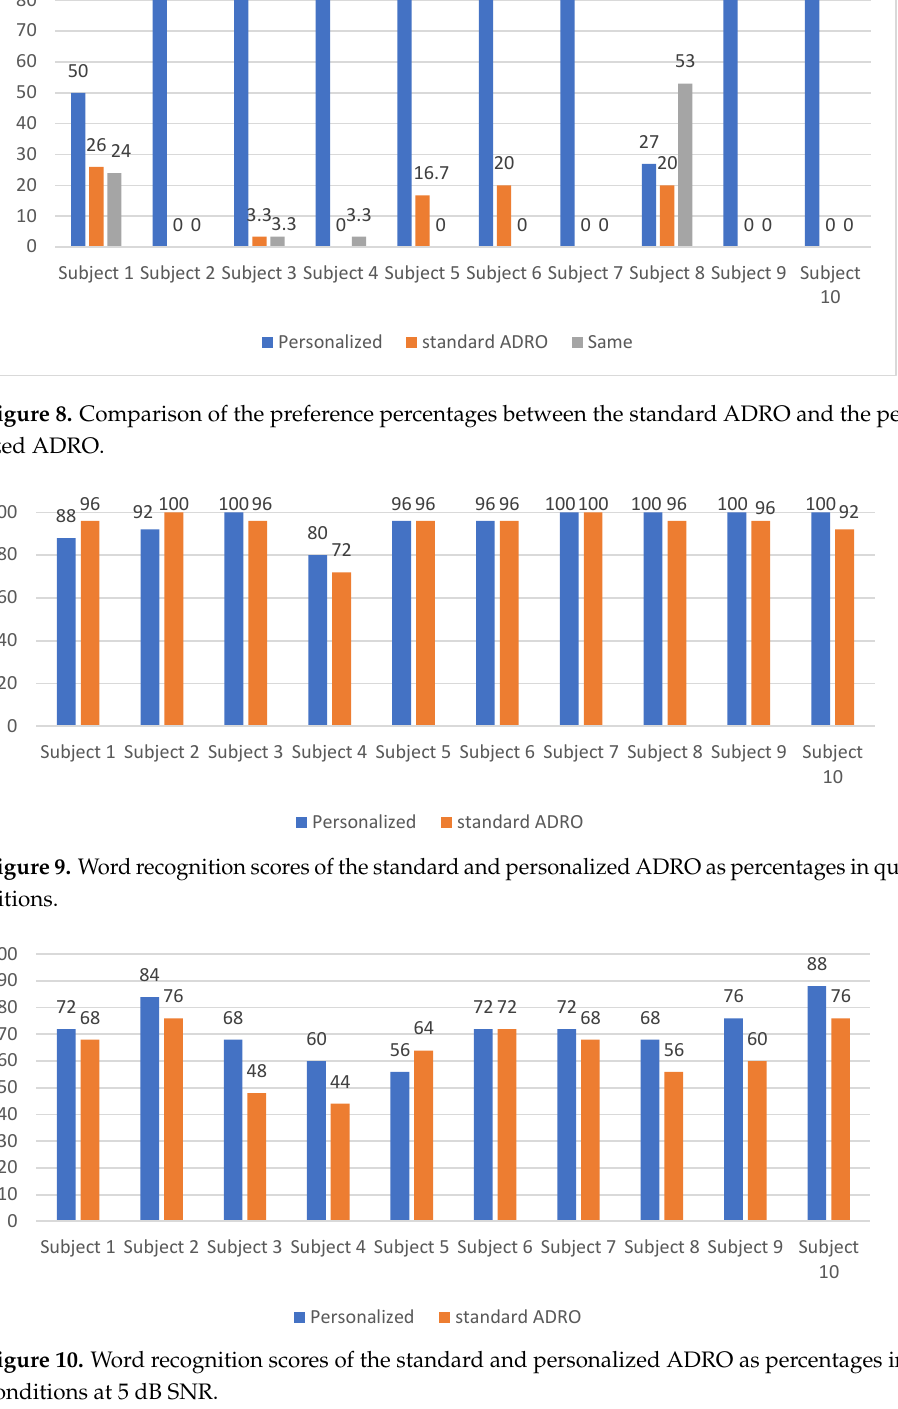
Figure 10. Word recognition scores of the standard and personalized ADRO as percentages in noisy conditions at 5 dB SNR.